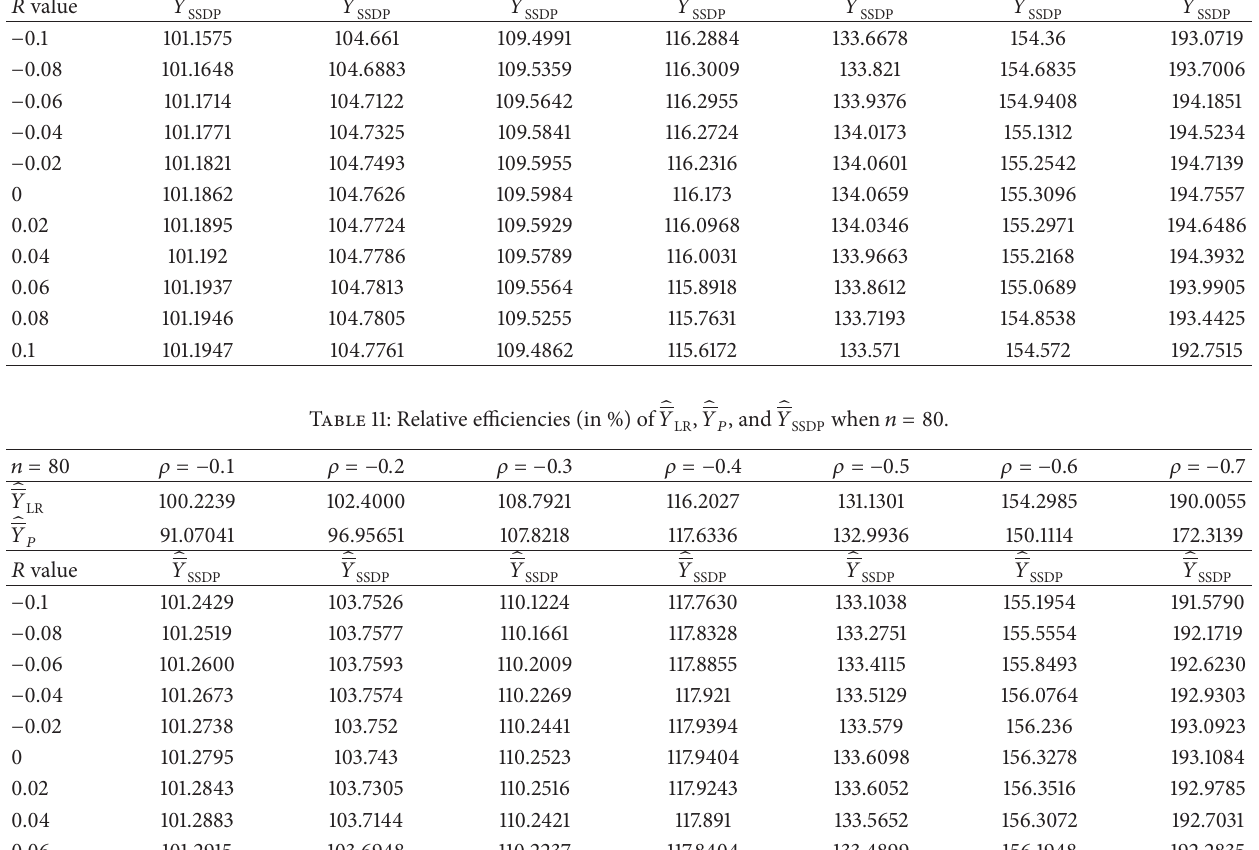
̂ 𝑌 when 𝑛 = 60 . SSDP